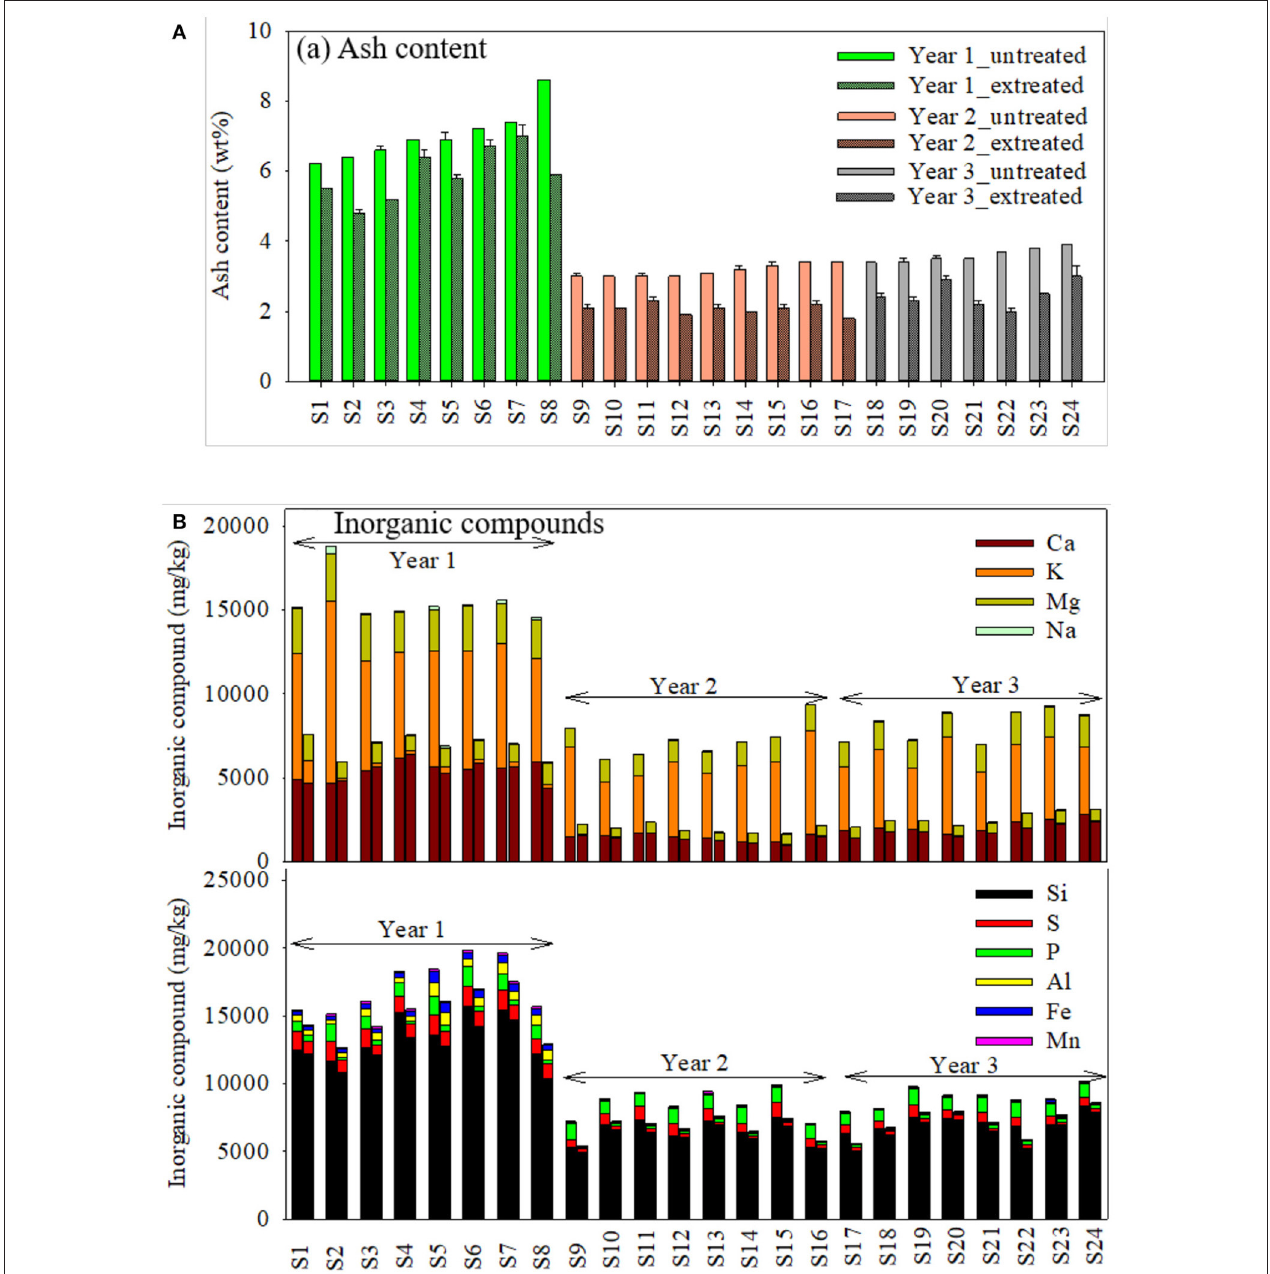
FIGURE 2 | Ash content and inorganic compounds in switchgrass (untreated and the corresponding treated) samples harvested for three consecutive years. (A) Ash content and (B) inorganic species in the untreated (first stack) and treated switchgrass (second stack).